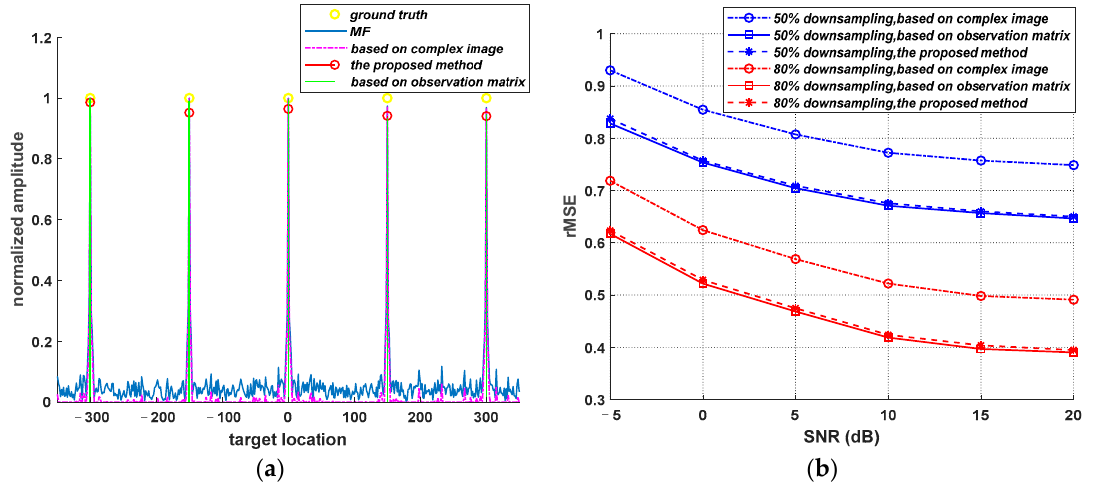
Figure 2. 1D simulation results. ( a ) The reconstructed images obtained by MF, parameter estimation method based on observation matrix, parameter estimation method based on complex image and the proposed method. ( b ) The RMSE curves of three parameter estimation methods at different SNR and downsampling rate.